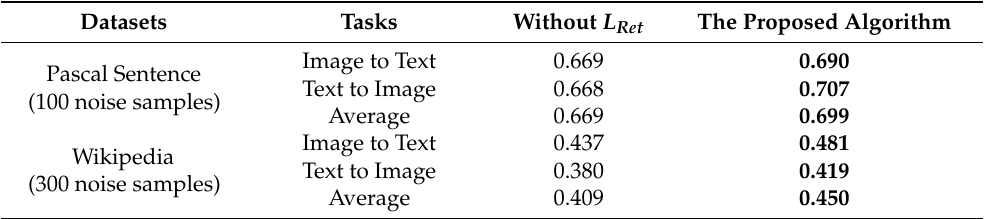
Table 7. The mAP values of the cross-modal retrieval performance on the Pascal Sentence and Wikipedia datasets, which contain 100 and 300 noise samples,